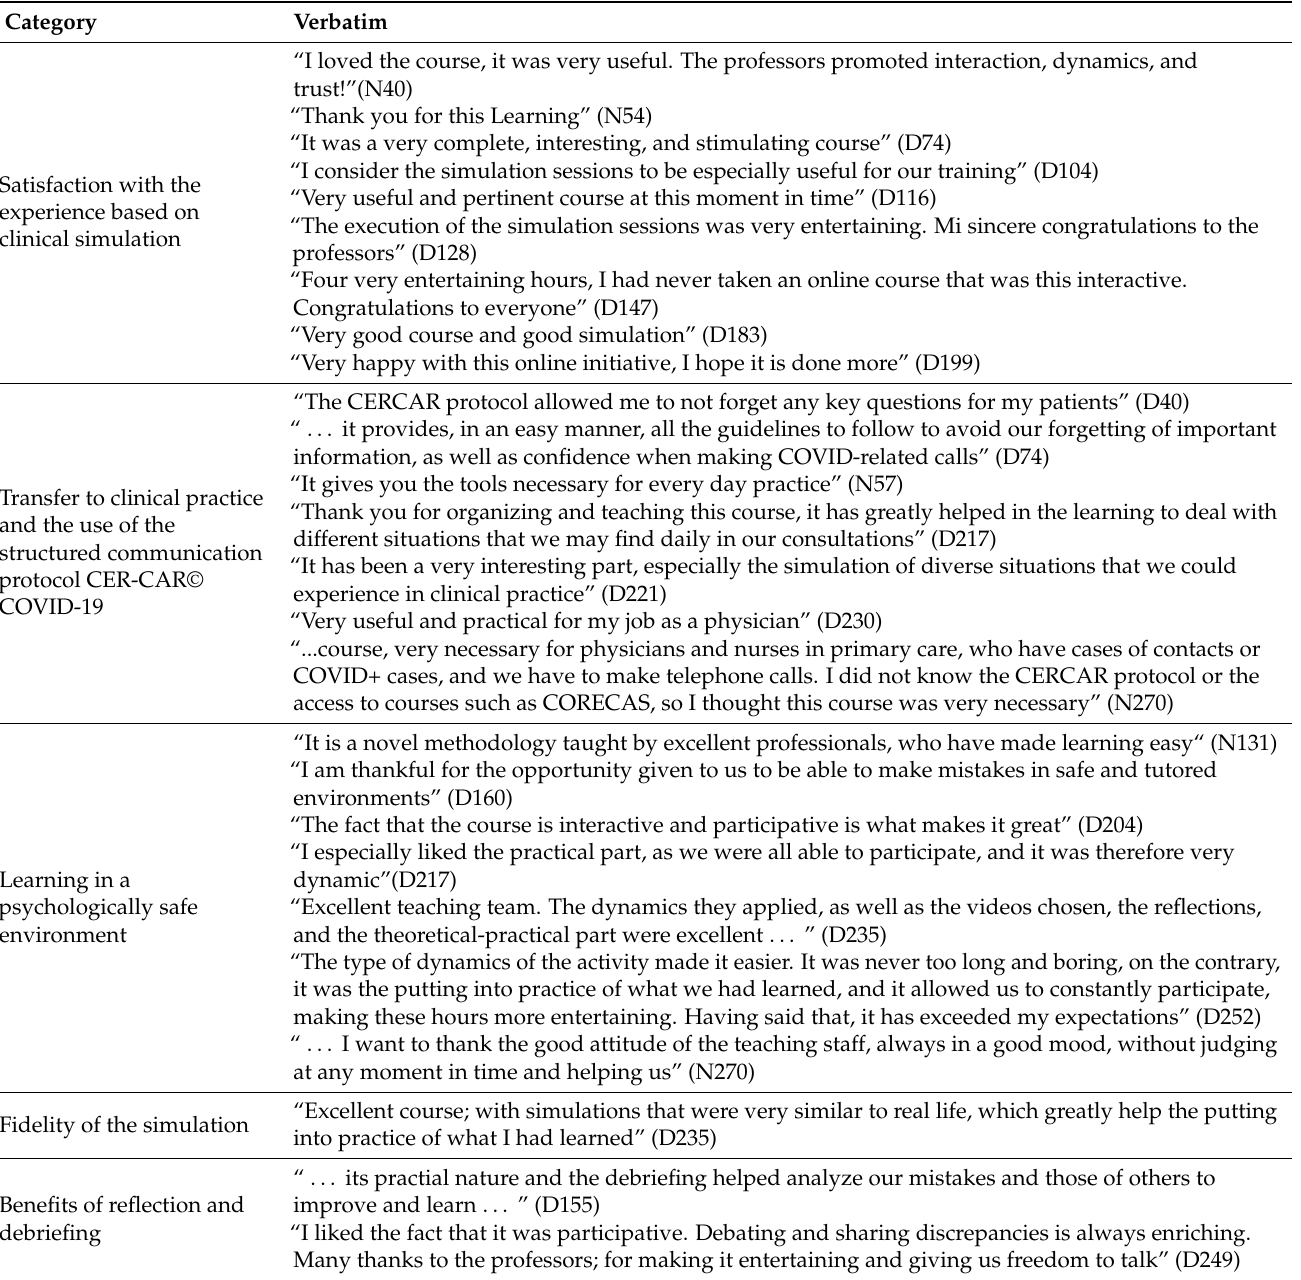
Table 7. Verbatim text of the categories identified after the thematic analysis of the participant’s